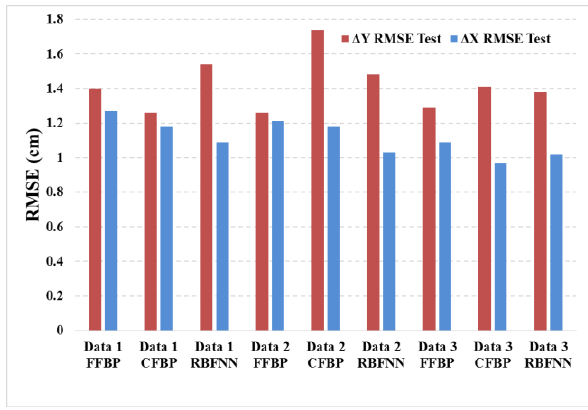
Figure 6. Graphical representation of the performance statistics calculated using FFBP, CFBP and RBFNN methods in control